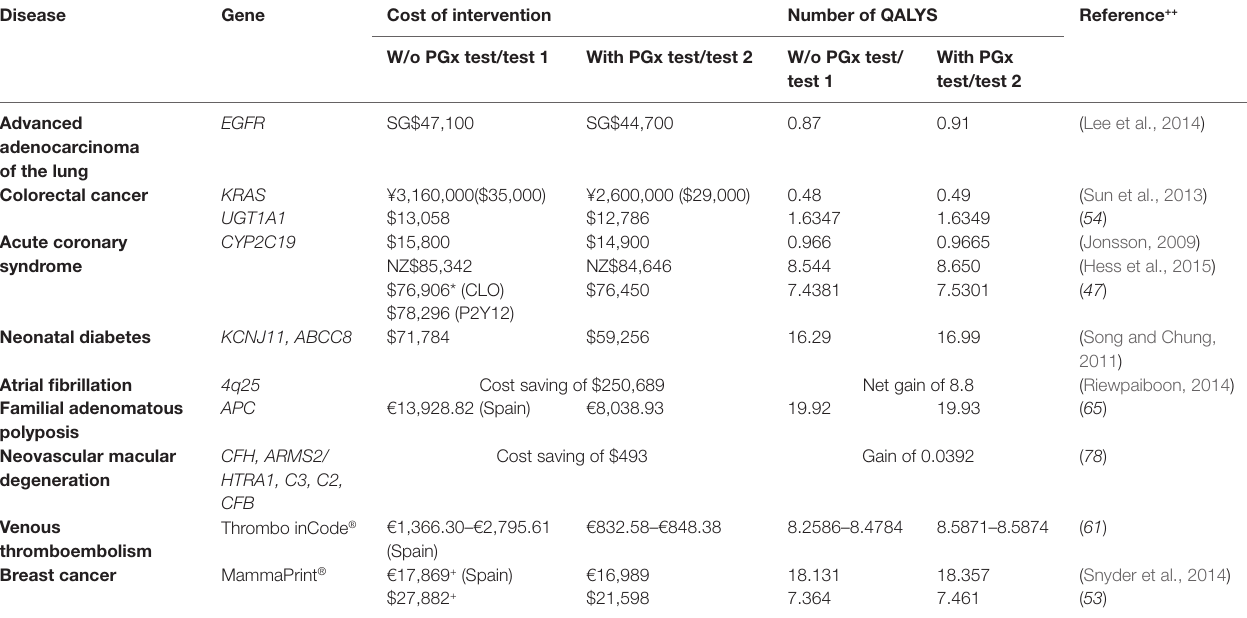
TABLE 1 | Cost and number of quality-adjusted life years (QALYs) of “dominant” individualized interventions. Disease